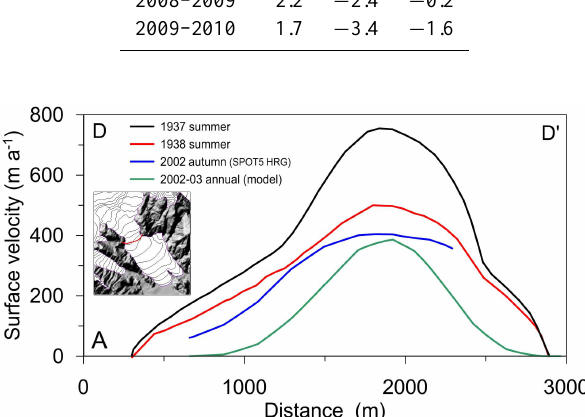
correlation of 2.5m resolution SPOT5 HRG satellite images. Reli- able annual velocity measurements were only obtained in the vicin- ity of the locations 1–3 shown in Fig.